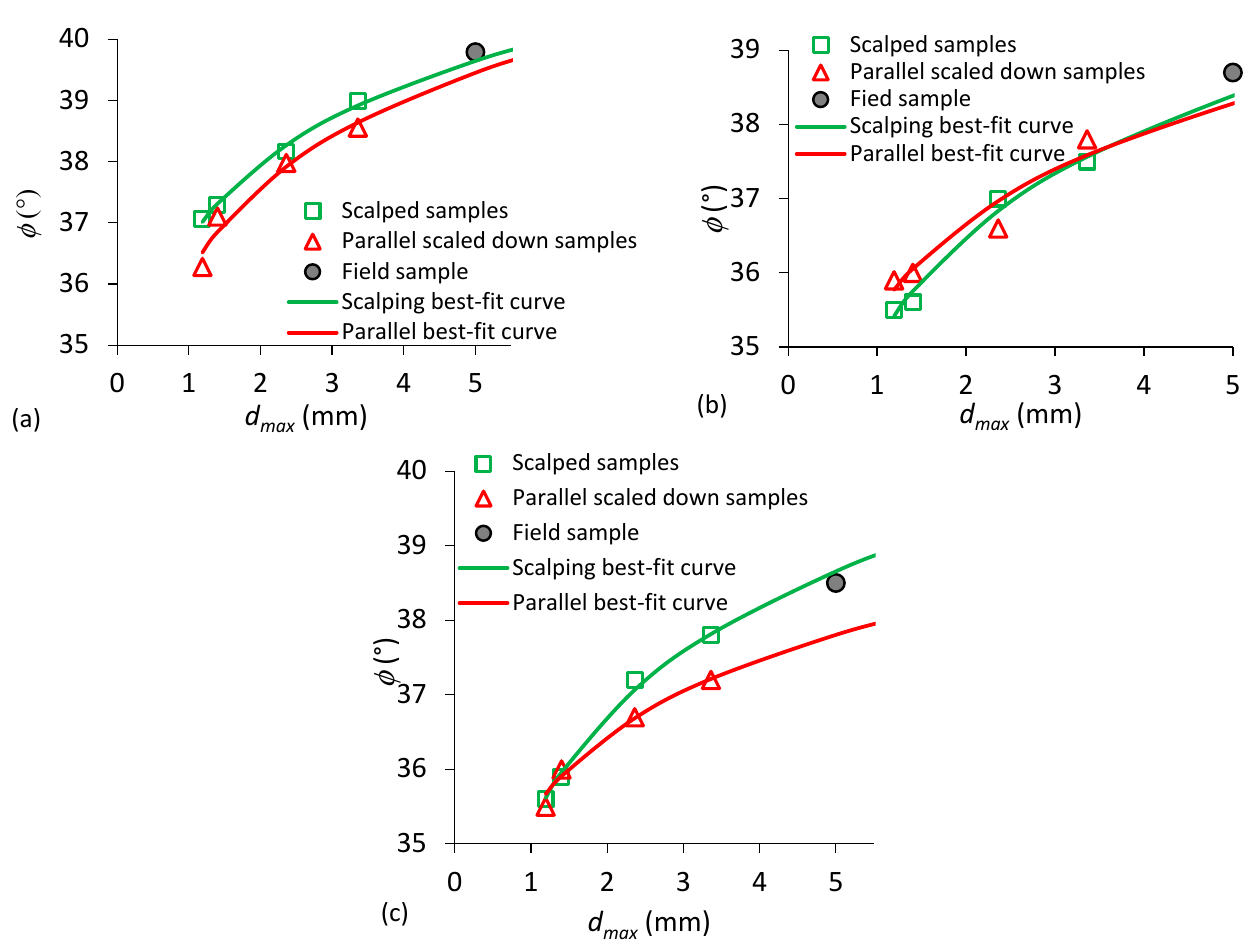
Figure 6. Variations of average φ values as a function of d max , obtained by direct shear tests on scaled down and field samples ( a ) M1, ( b ) M2 and ( c ) M3. Table 6. The φ values of field samples measured and predicted by applying the scalping and parallel prediction equations for field samples of M1, M2 and M3.